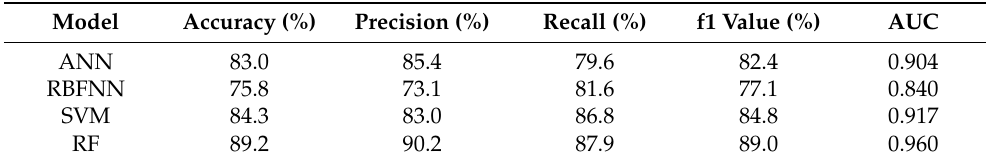
Table 6. Evaluation results of the four